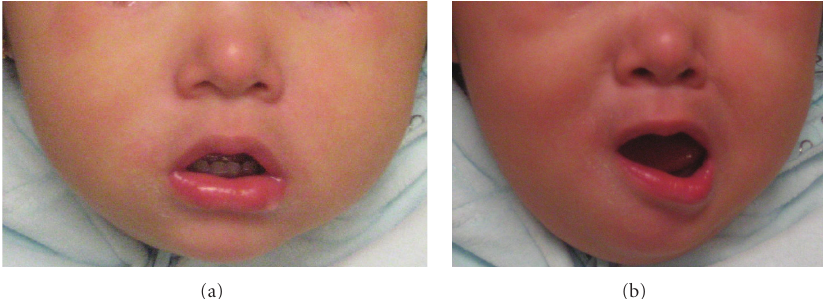
Figure 1: Child with right-sided asymmetric crying face at rest (a) and crying (b). The lower lip is pulled toward the intact left side.